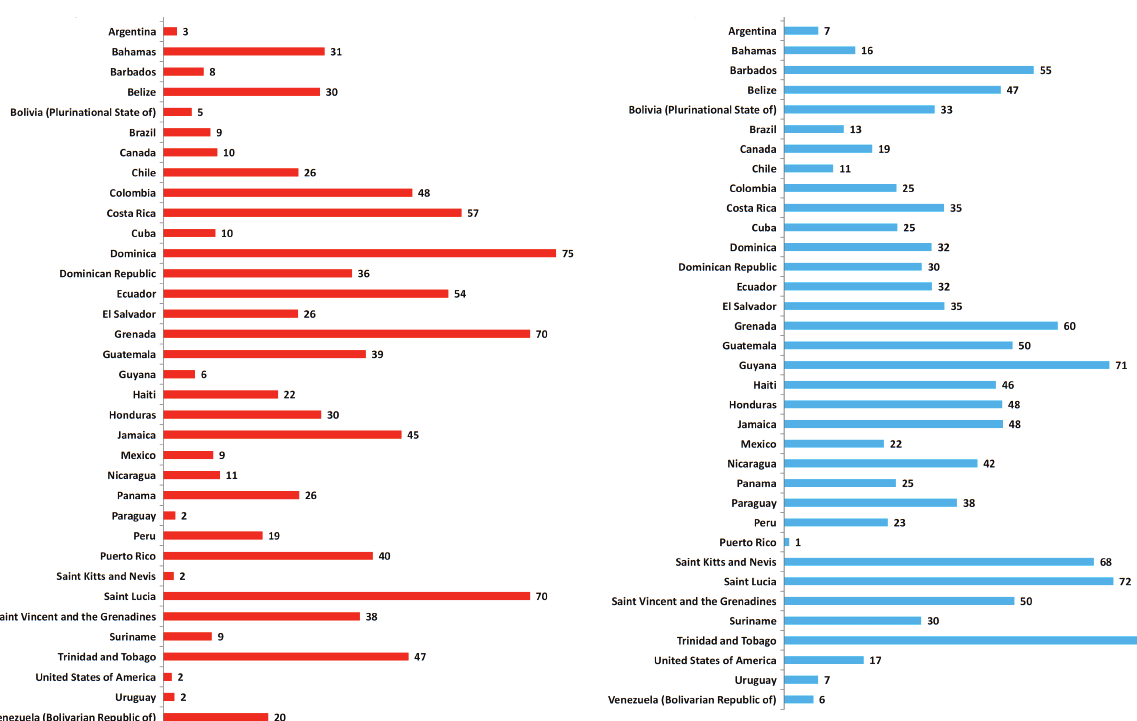
Figure 1: Values of permanent crops to cultivated area (%) in 2011 Figure 2: Values of rural population to total population (%) in